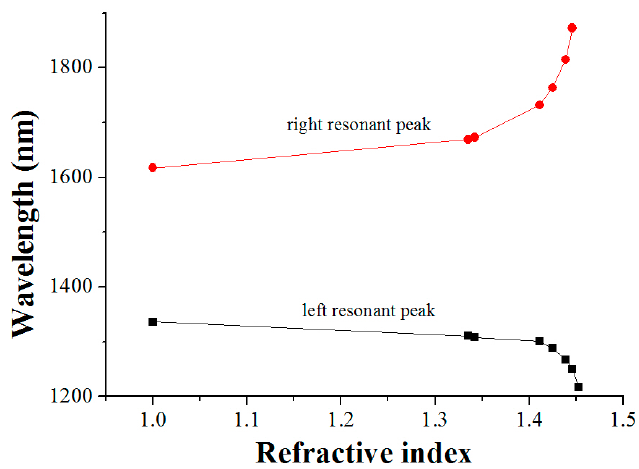
Figure 4. The relationship between the resonant wavelength and RI.